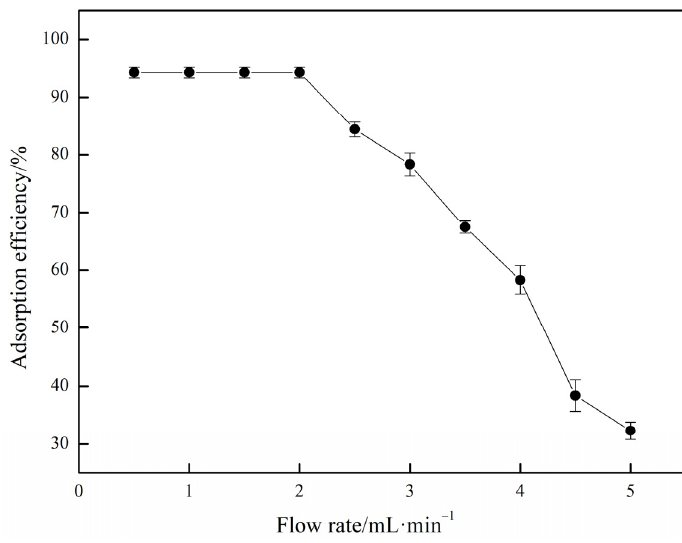
Figure 5. Effect of flow rate on the adsorption efficiency.